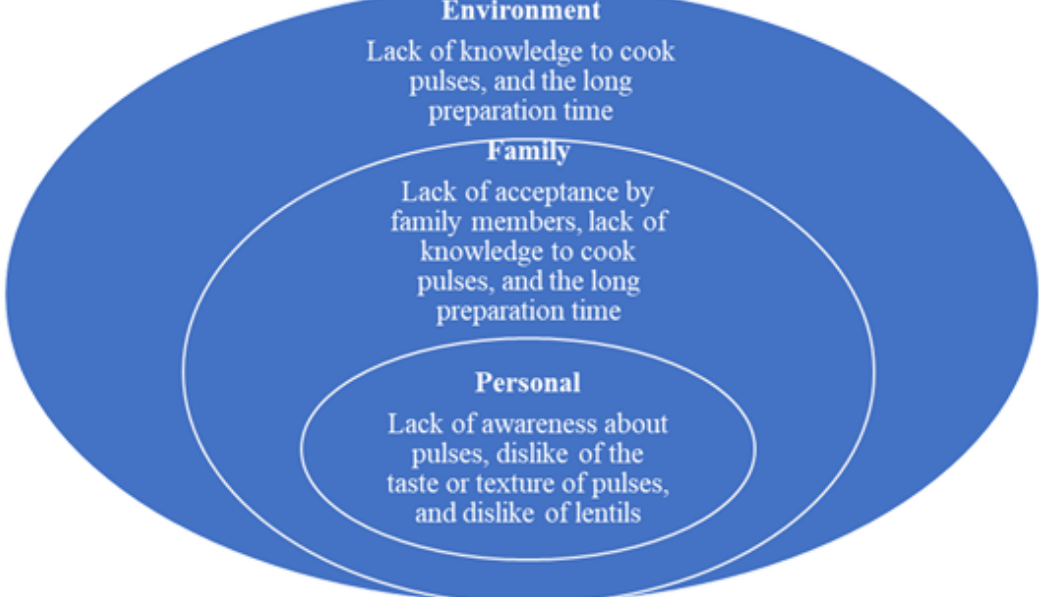
Figure 1. Individual, social, and environmental determinants of pulse consumption among preschool children based on literature